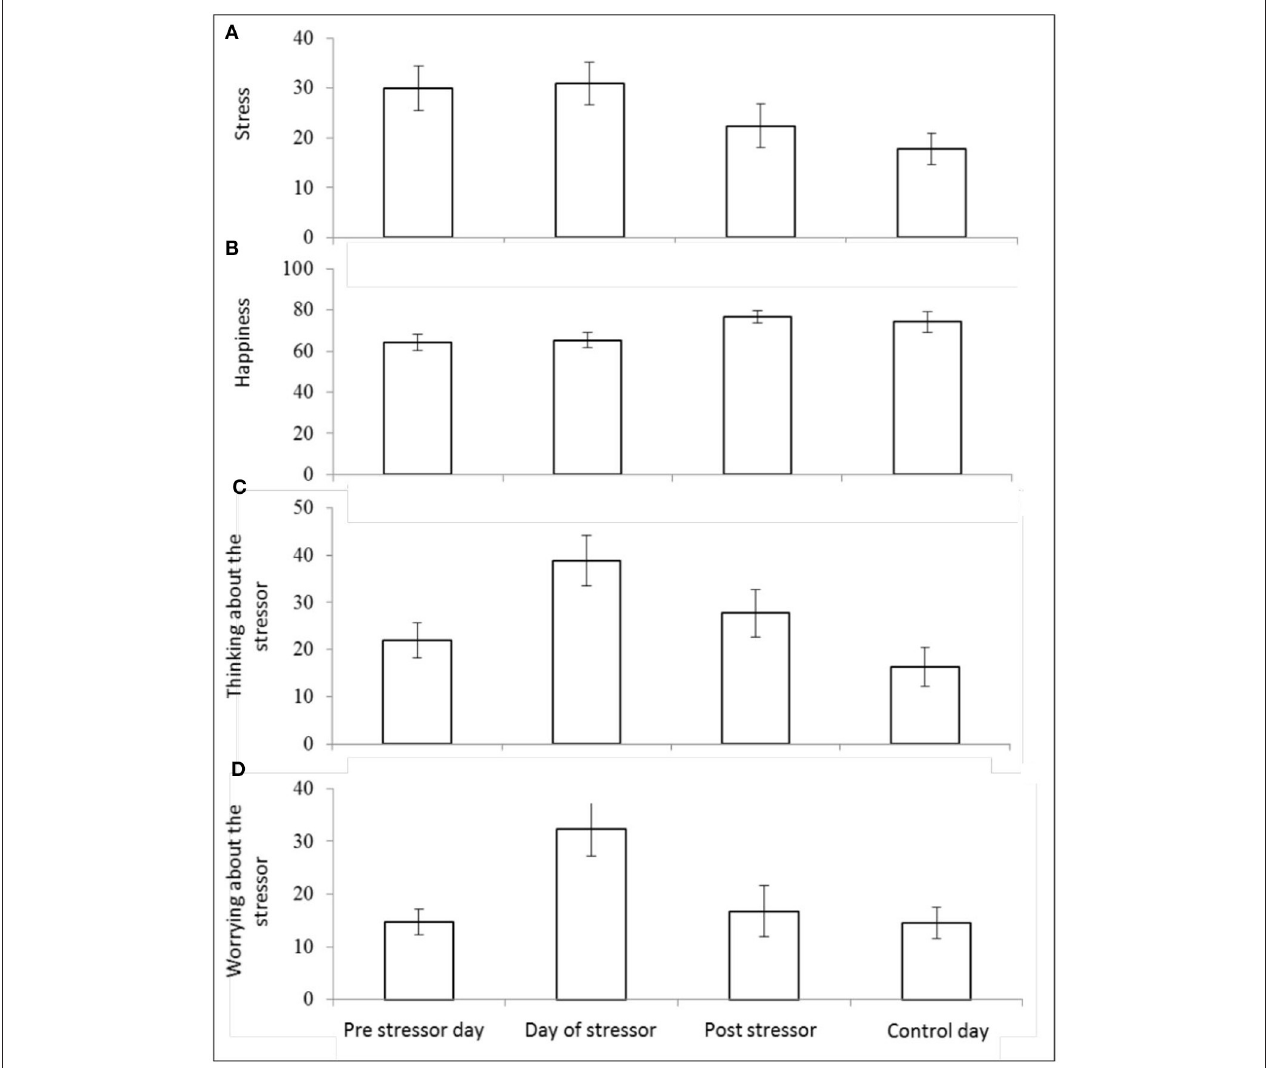
FIGURE 6 | Mean (and SE) morning self-reported stress (A) , happiness (B) , “thinking about” the stressor (C) , and “worrying about” the stressor (D) , assessed over four sampling